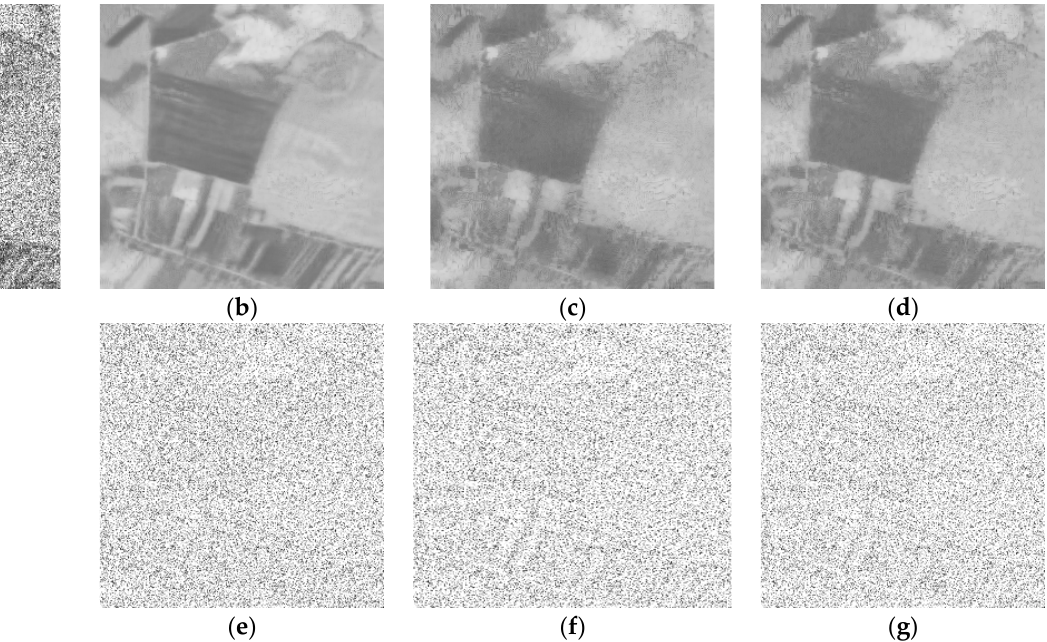
Figure 8. The results of the candidate combinations on RS1, and the bottom row are the corresponding ration images. ( a ) Noisy image; ( b ) Fusion #1; ( c ) Fusion #2; ( d ) Fusion #3; ( e ) Fusion #1; ( f ) Fusion #2; ( g ) Fusion #3. Table 2. The FSIM, PSNR, and ENL of the candidate combinations. (FSIM, PSNR, and ENL1 are computed on S2; ENL2 is computed on